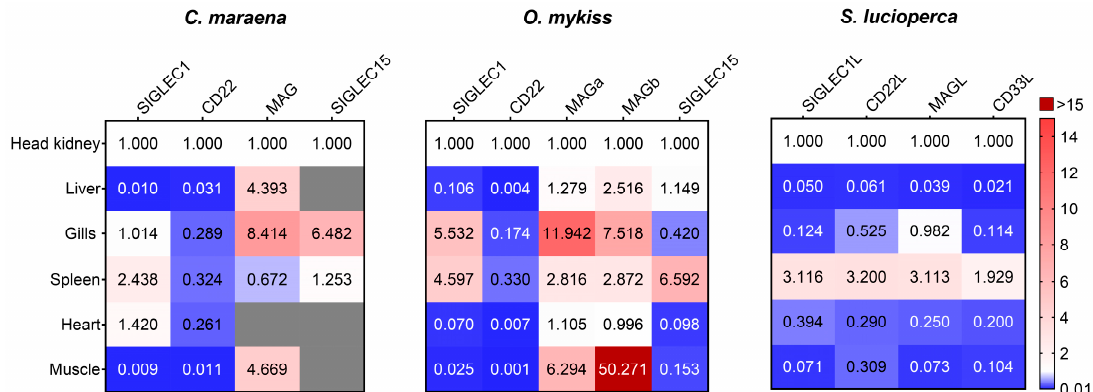
Figure 1. Tissue-specific expression of Siglec1 , CD22 , MAG , and Siglec15 / CD33L in maraena whitefish ( C. maraena ), rainbow trout ( O. mykiss ), and pikeperch ( S. lucioperca ). The qPCR data were normalized by three reference genes. The resulting transcript numbers from the head kidney (HK) were set at 1.0, and the transcript numbers of the same gene in all other tissues were expressed as fractions. Lower and higher transcript values than those of the HK are highlighted in blue and red, respectively, according to the given color code. Non-detectable transcript numbers are indicated by gray